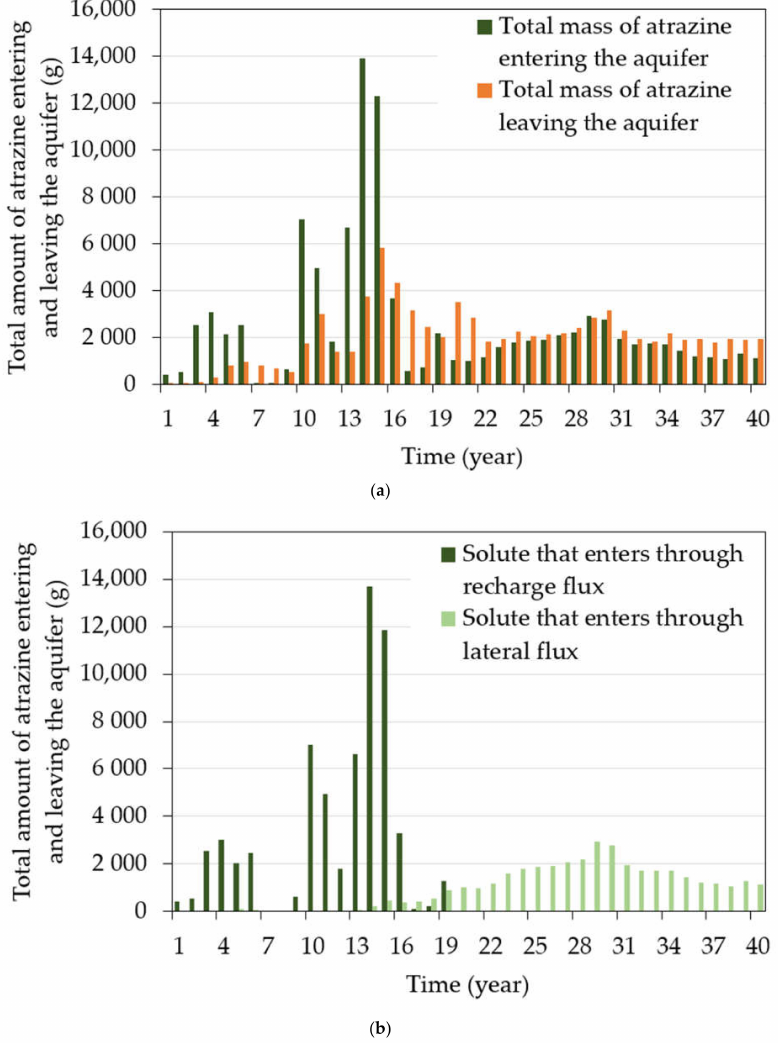
Figure 11. The total mass of atrazine that is entering the aquifer through various sources and leaving the aquifer through various sinks ( a ), and the total mass of atrazine that is entering the aquifer through lateral inflow and recharge ( b